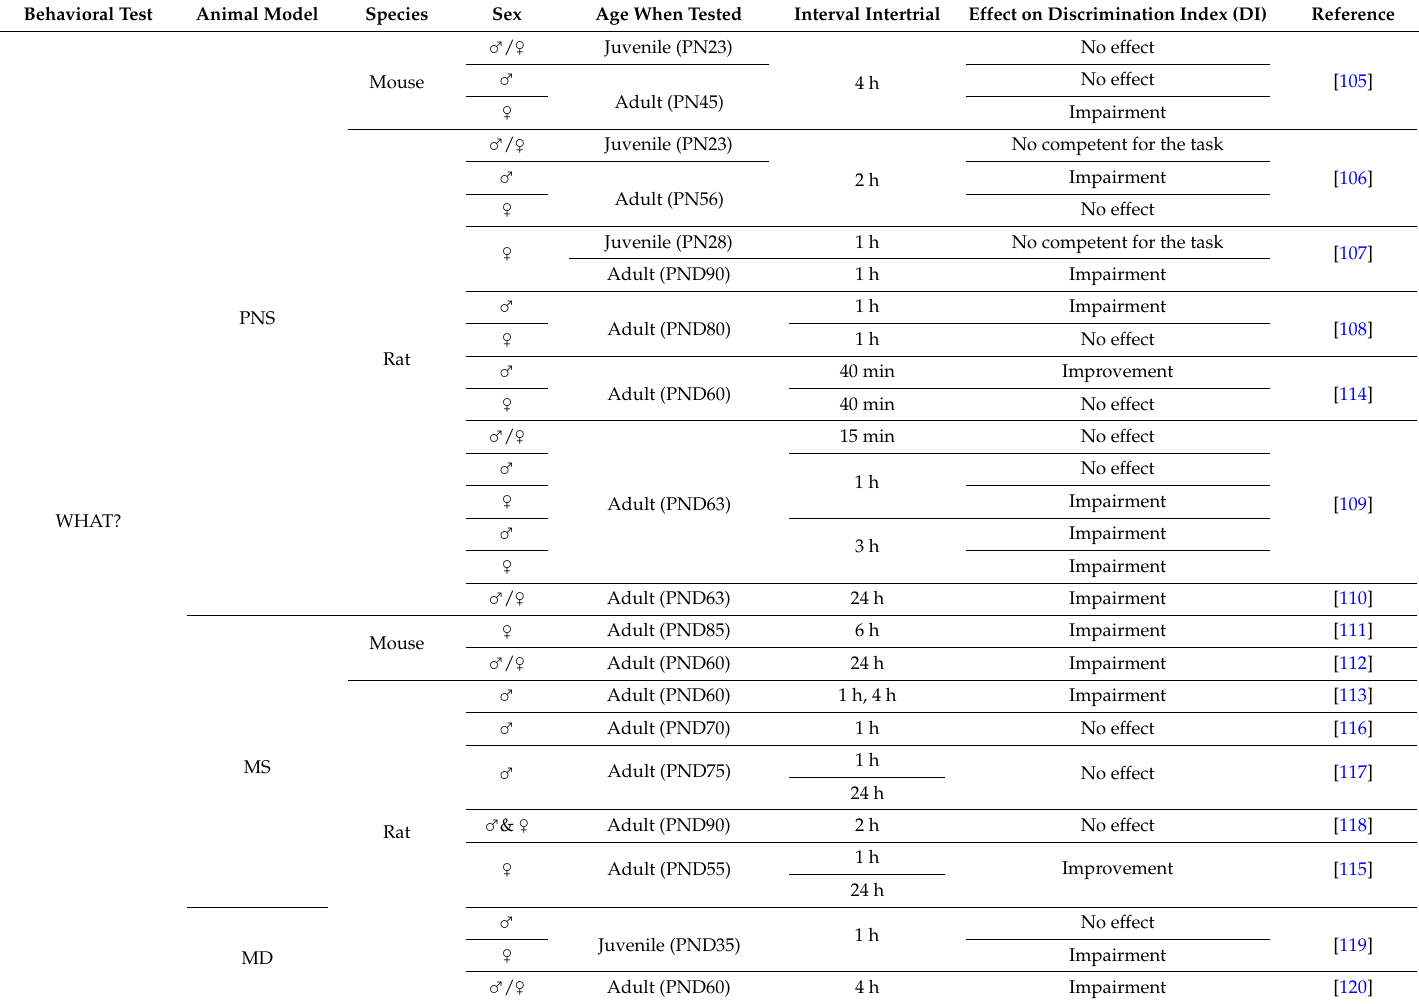
Table 3. Episodic-like memory performances in rodent models of